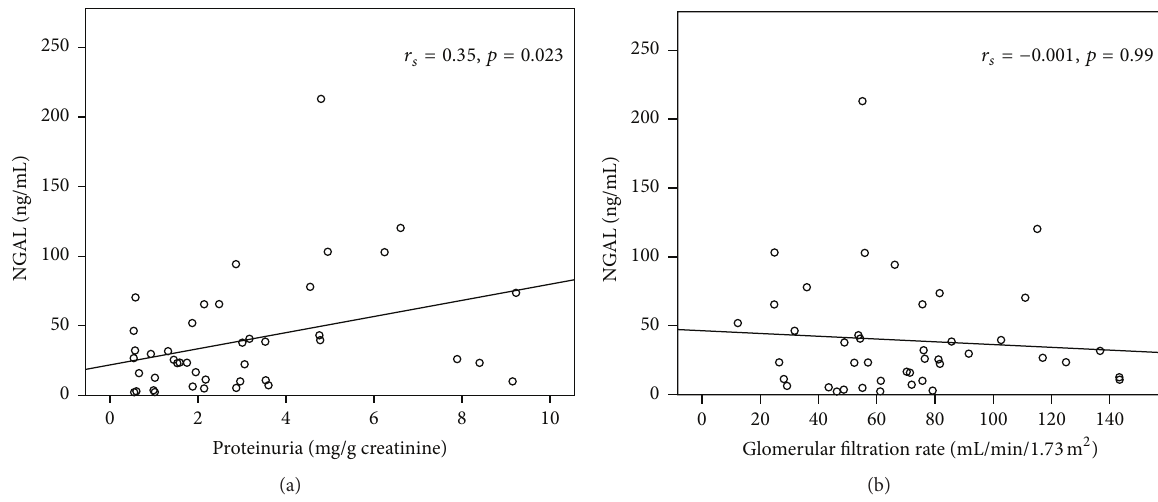
Figure 1: Relationship between NGAL and other laboratory parameters at baseline. (a) Proteinuria at baseline and (b) glomerular filtration rate at baseline ( 𝑛 = 43 ).